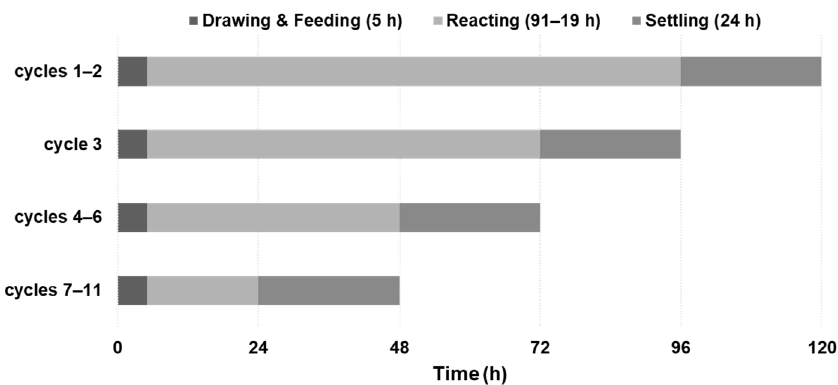
Figure 3. SBR operation with adjustable cycle duration during phase 2.